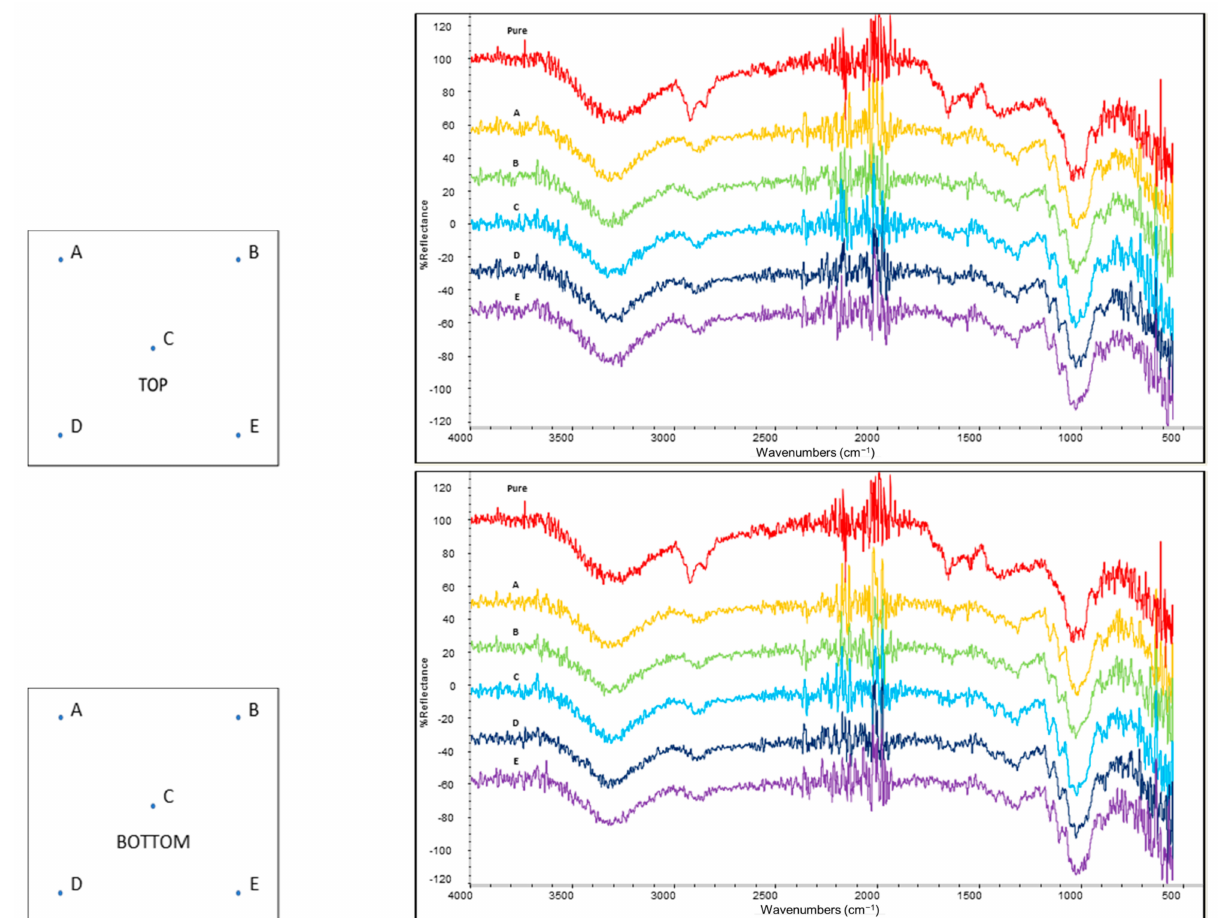
Figure 7. Spectra of the top and bottom part of antioxidant-treated tissues compared with IR spectrum of pure antioxidant extract (red). Capital letter on each spectrum indicate the point where it was acquired according to the relative picture on its left.